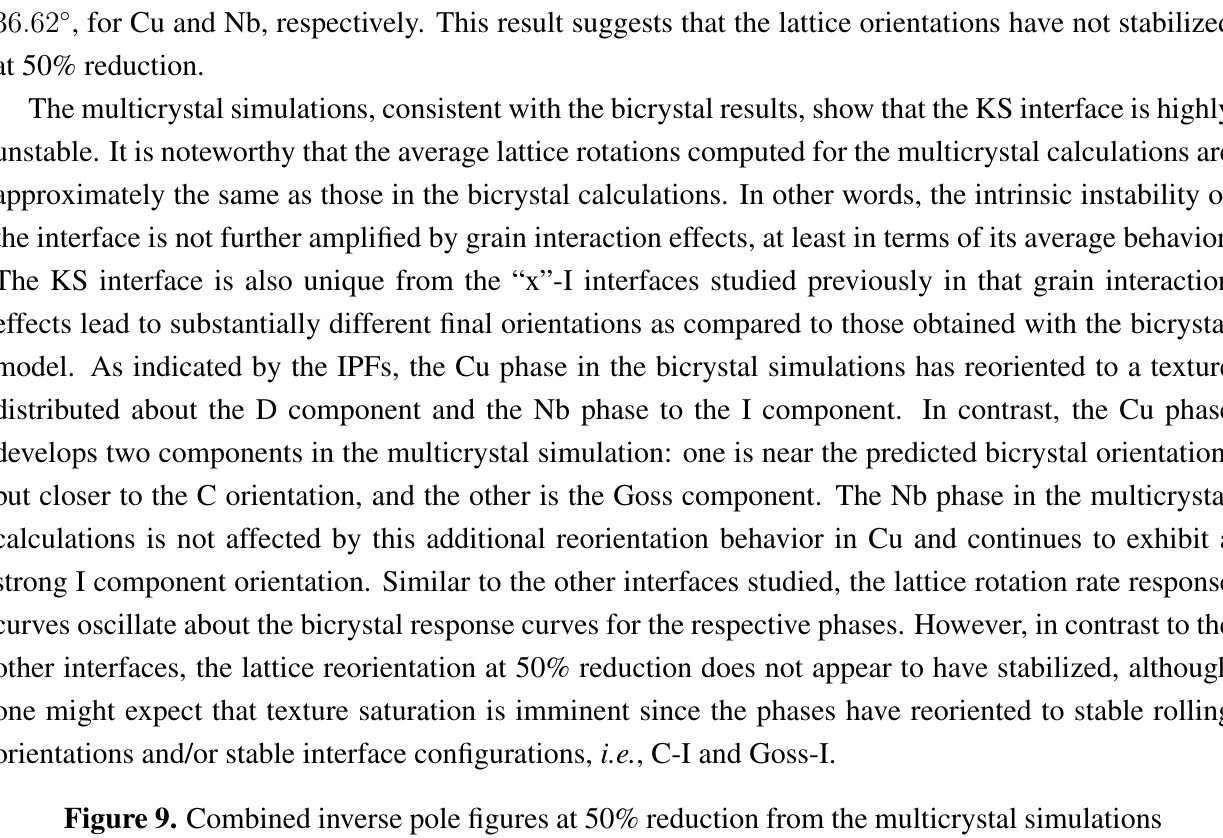
Figure 9. Combined inverse pole figures at 50% reduction from the multicrystal simulations for the ( a ) copper phase in the KS interface; and ( b ) niobium phase in the KS interface. The final orientations obtained from the periodic bicrystal simulations are indicated by the filled black circles. RD [100] / TD [010] / ND [001]